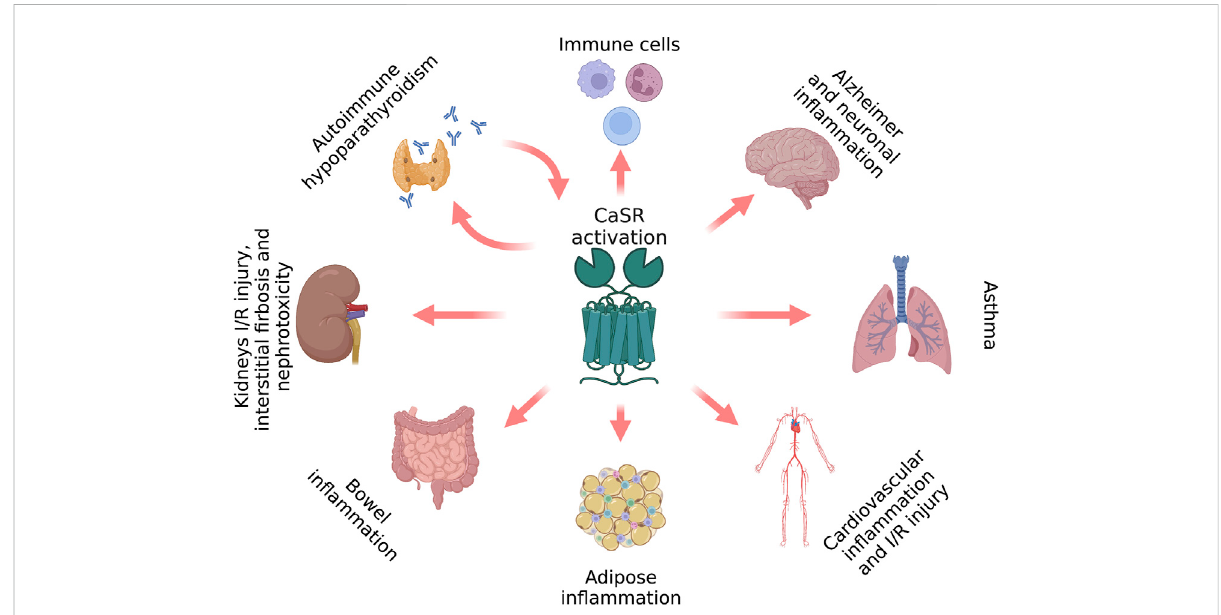
FIGURE 1 CaSR-induced in fl ammatory hallmarks ( fi gure drawn with Biorender.com, accessed on 27 October